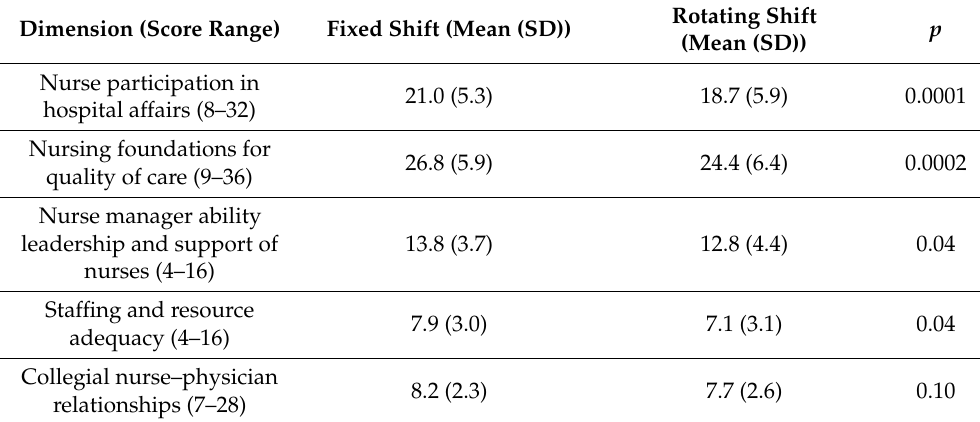
Table 7. PES-NWI